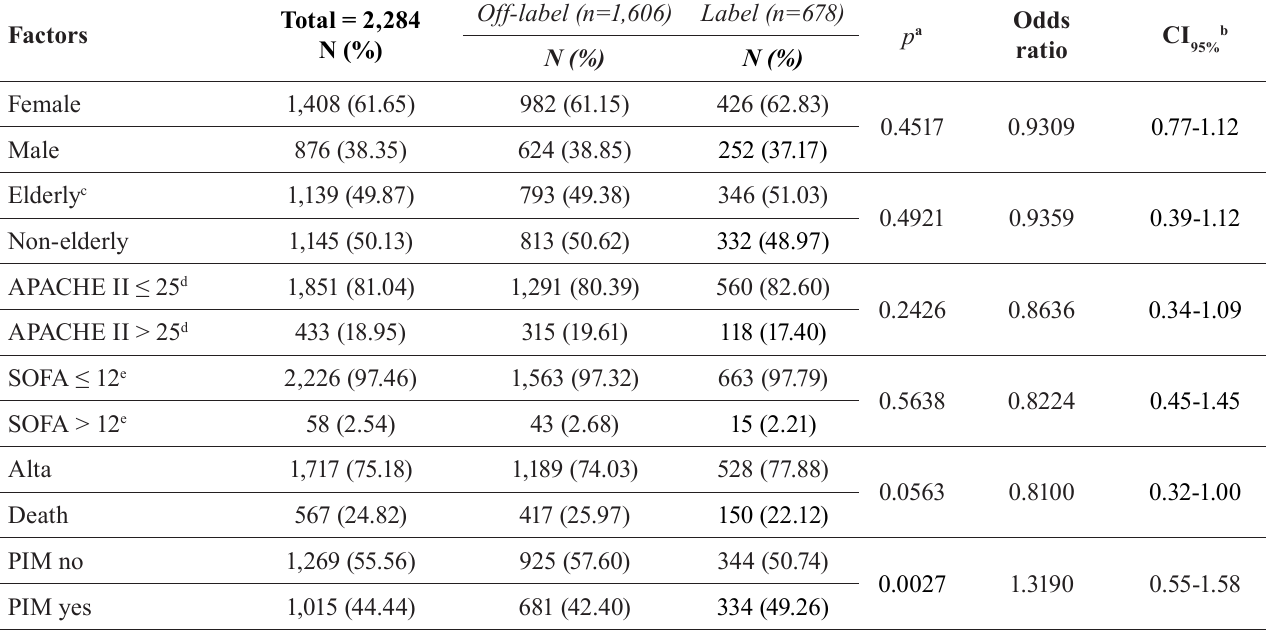
TABLE II – Comparison of off-label and label drug use regarding demographic and clinical data and prescription of Potentially Inappropriate Medicines (PIM)